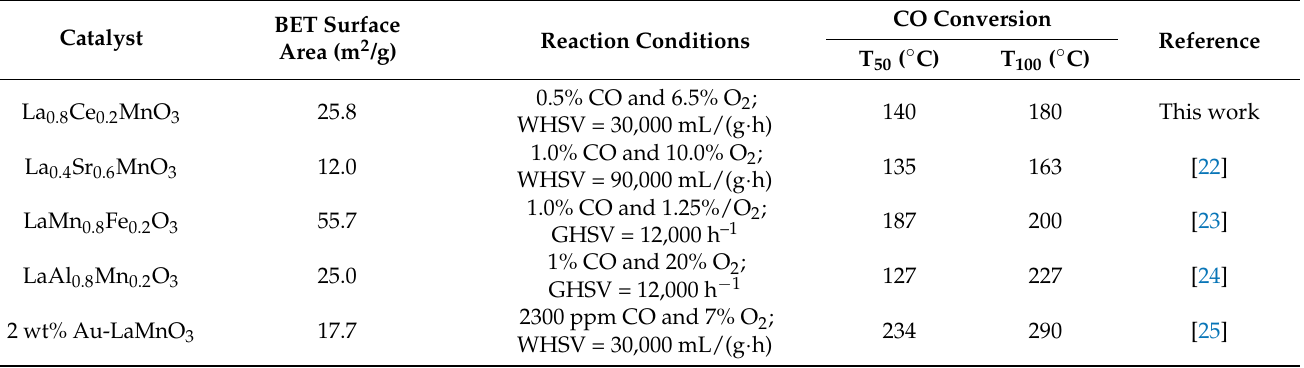
Table 1. Comparison of BET surface area and CO conversion with other reported works.